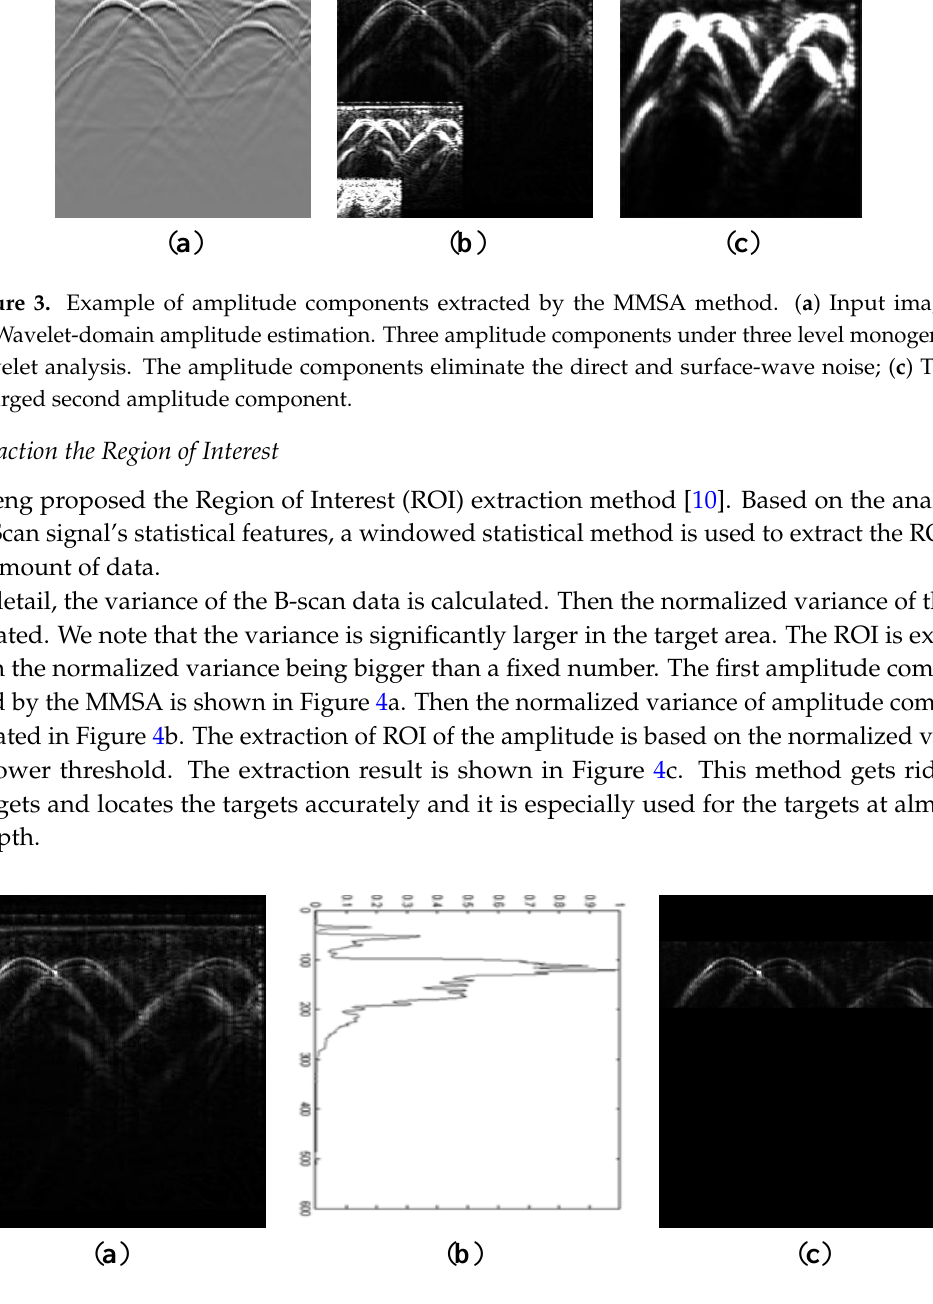
Figure 4. Example of the extraction of Region of Interest. ( a ) The first amplitude modulation component extracted by using the MMSA; ( b ) The normalized variance of amplitude component; ( c ) The extraction of ROI of the amplitude based on the normalized variance with a lower threshold.